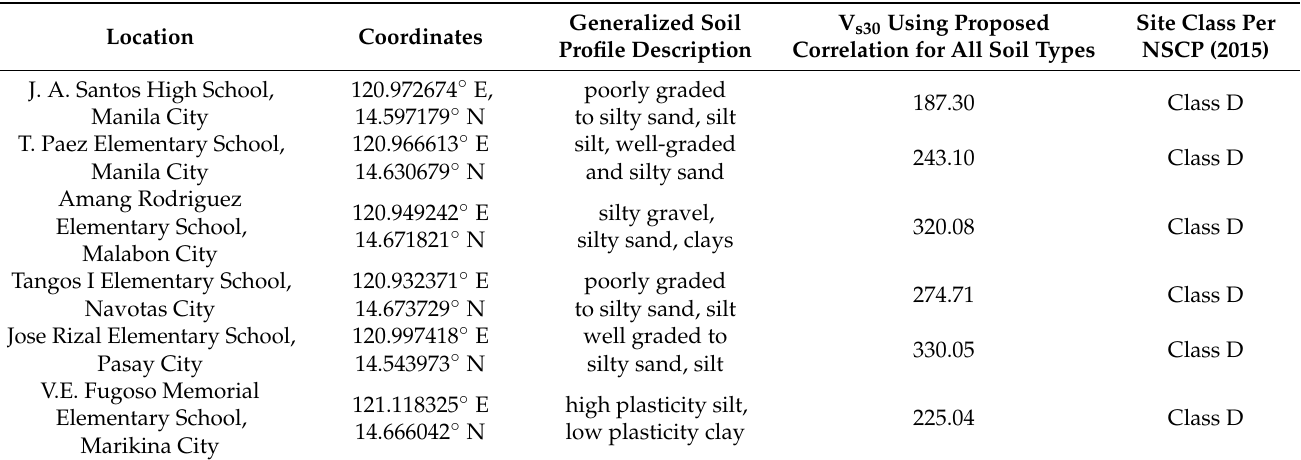
Table 5. Typical average shear wave velocity to a 30-m depth (V s30 ) of all soils at various locations in Metro Manila.